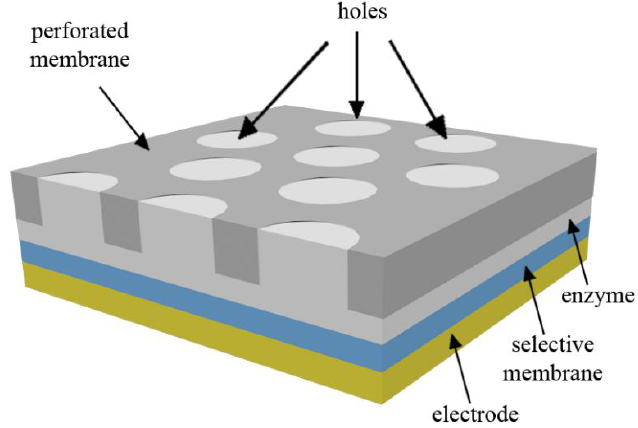
Figure 1. Schematic view of the biosensor with cylindrical holes .